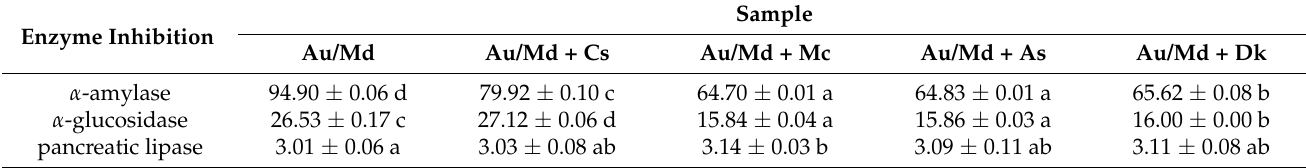
Figure 2. Determination of intracellular ROS production. ROS level, visualized as H2-DCF-DA fluorescence and expressed as % of the control samples (non-oxidized nor pretreated samples), in Caco-2 after 60 min incubation with TBH 2.5 mmol/L and pretreated with the extracts (0–20 µ g/mL) of five selected fresh final products (Au/Md, Au/Md + Cs, Au/Md + Mc, Au/Md + As, and Au/Md + Dk) ( µ g/mL, 30 min). # = p < 0.001 vs. control; * = p < 0.05 vs. TBH 2.5 mmol/L; *** = p < 0.001 vs. TBH 2.5 mmol/L. Table 2. Digestive enzyme inhibitory activities (IC 50 , mg fw/mL) of analysed strawberry tree/apple fruit